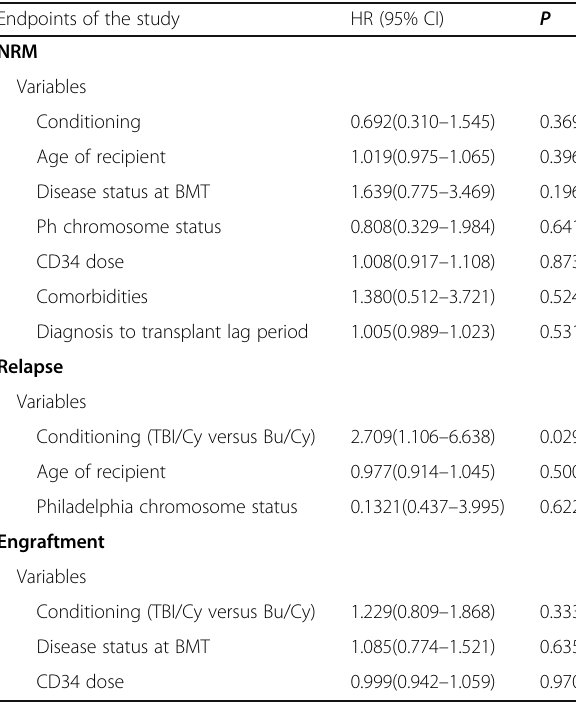
Table 3 Multivariate analysis of non-relapse mortality,